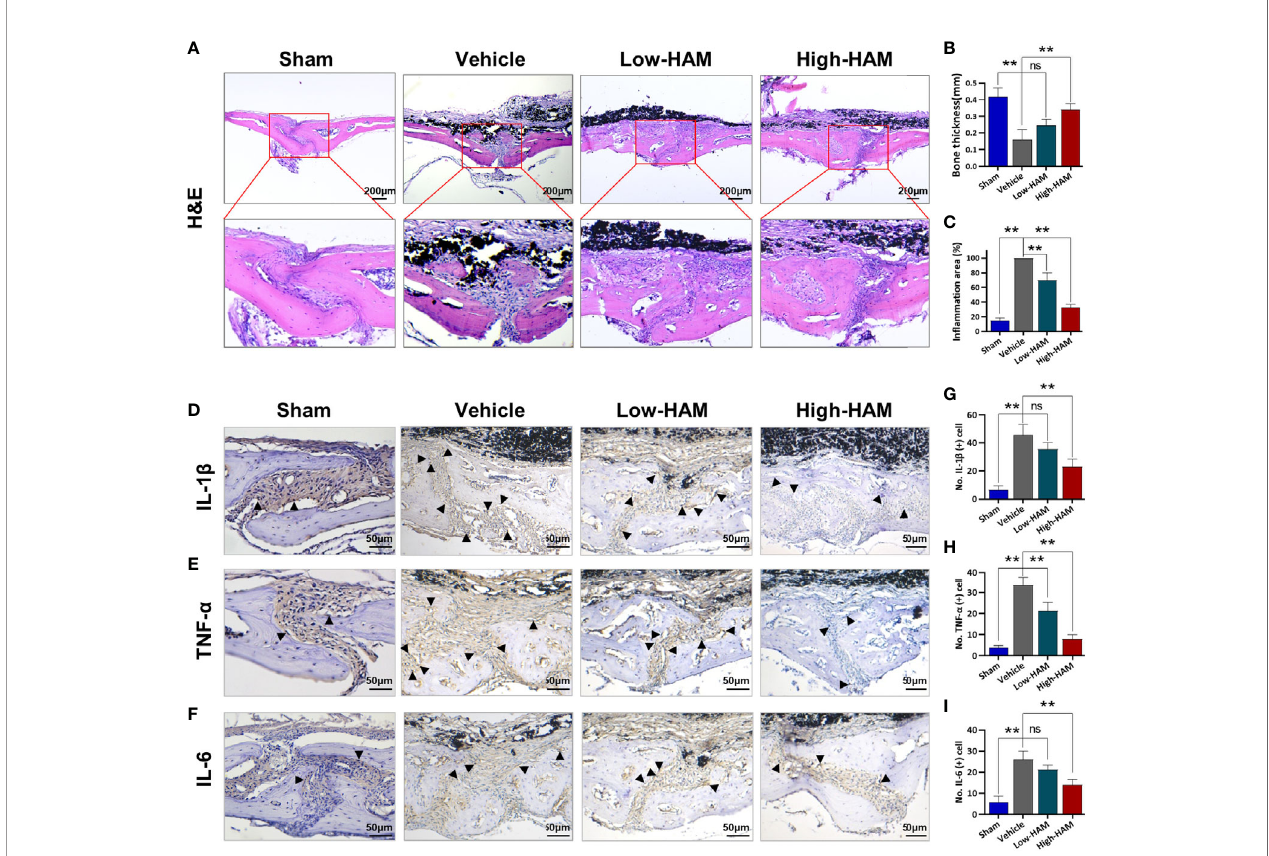
FIGURE 2 | Harmine reduced the in fl ammatory in fi ltrate and cytokines expression. (A) Histological staining of (H&E). (B) Bone thickness. (C) In fl ammation area. Immunohistochemical staining of in fl ammatory factors: (D) IL-1 b , (E) TNF- a , and (F) IL-6. Number of positive cells: (G) IL-1 b , (H) TNF- a , and (I) IL-6. Scale bar indicates 200 and 50 m m. n = 3. All data were expressed as the mean ± SD, ns. no signi fi cance, ** p < 0.01, compared with the vehicle group.